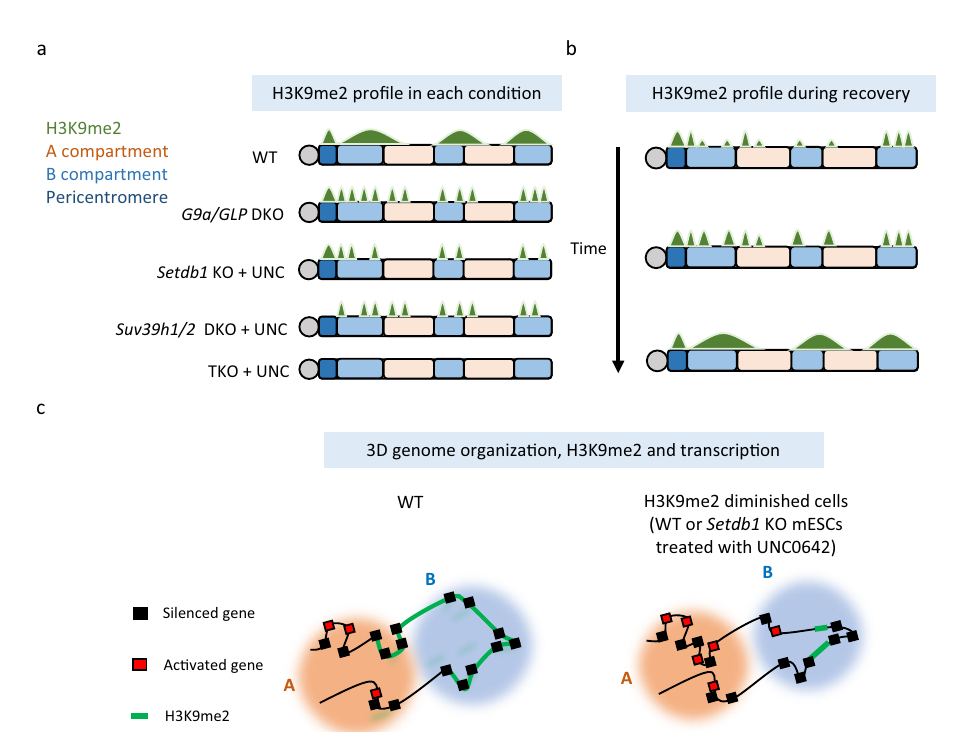
Fig. 6 Summary of this study. a Although H3K9me2 (shown in green) is largely mediated by G9a/GLP in mESCs, some residual H3K9me2 is observed in G9a/GLP DKO mESCs. SETDB1 and SUV39H1/2 mediate G9a/GLP-independent H3K9me2 in a compartment-dependent manner. SETDB1 and